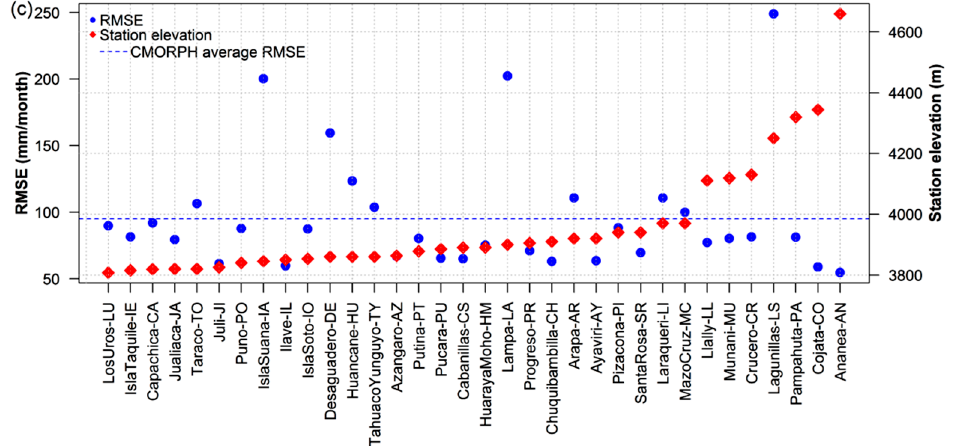
Figure 3. ( a ) R 2 of CMORPH compared with 34 RgSENAMHI in the LTb. ( b ) Bias of CMORPH compared with 34 RgSENAMHI in the LTb. ( c ) RMSE of CMORPH compared with 34 RgSENAMHI in the LTb.